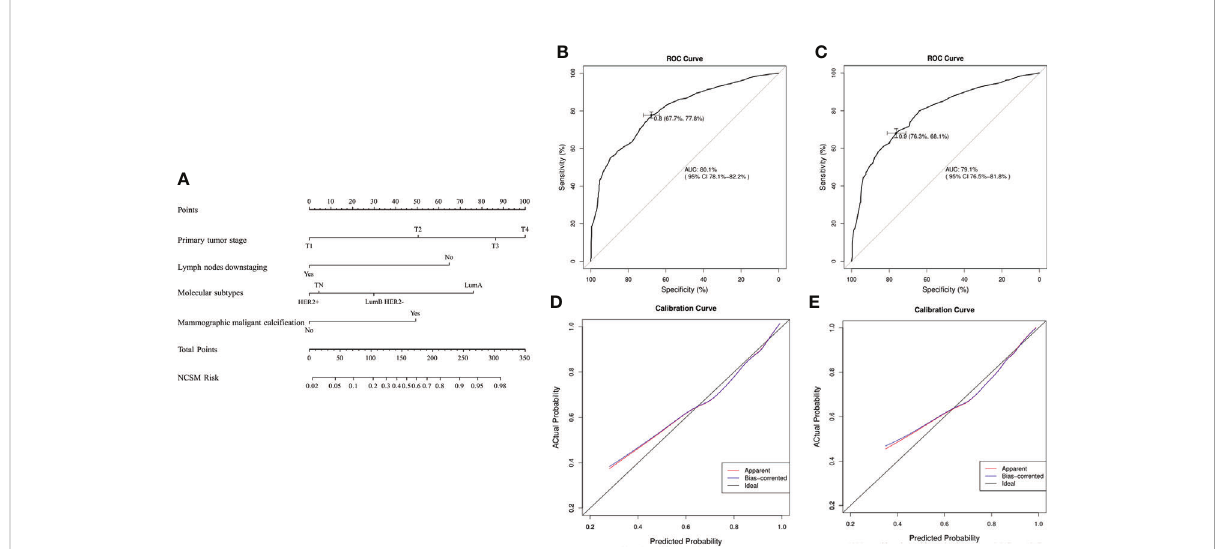
FIGURE 4 The nomogram to predict modi fi ed shrinkage classi fi cation modes after NAT. (A) : To calculate the probability of MNCSM, the scores for the four factors were summed up. And the total scores and bottom risk scale were referenced. (B) : The ROC curve in the training cohort indicates an AUC of 0.801. (C) : In the validation cohort, the ROC curve indicates an AUC of 0.791. The calibration curve showed a satisfactory fi t between the actual and predicted probability of achieving MNCSM in the training (D) and validation (E) cohorts. The horizontal axis indicates the predicted probability measured by the nomogram, and the vertical axis indicates the actual probability.